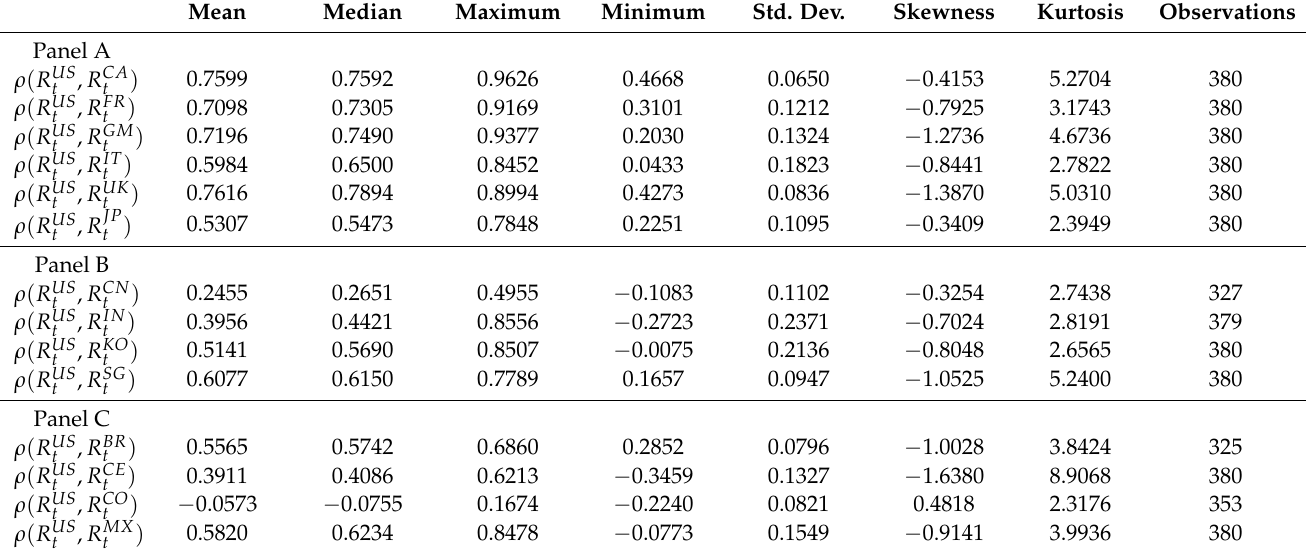
Table 8. Summary statistics of dynamic correlation coefficients for U.S. and global stock market